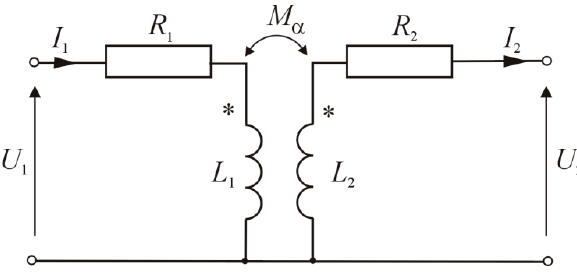
Figure 8. Circuit model with fractional ‐ order magnetic coupling.